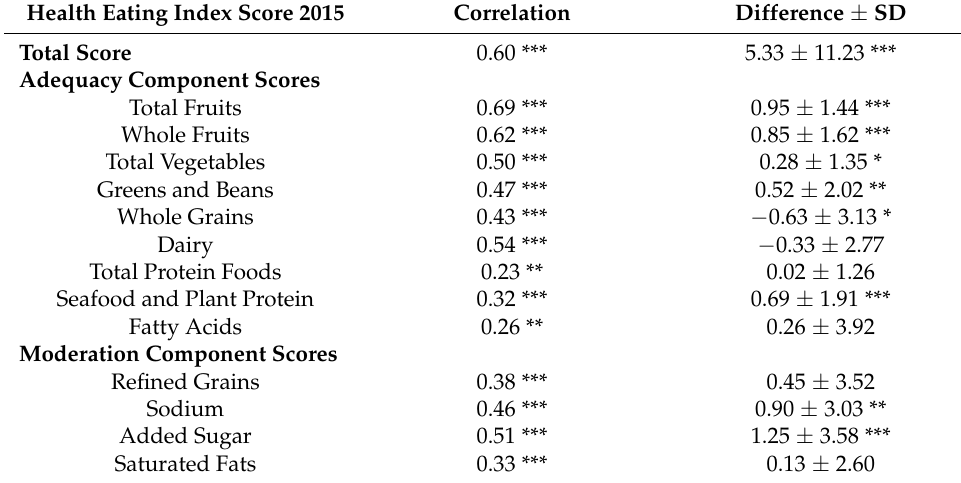
Table 3. Bivariate correlations and follow-up paired sample t-tests among heathy eating index scores generated using the Automated Self-Administered 24-h Dietary Assessment Tool and the Diet History Questionnaire